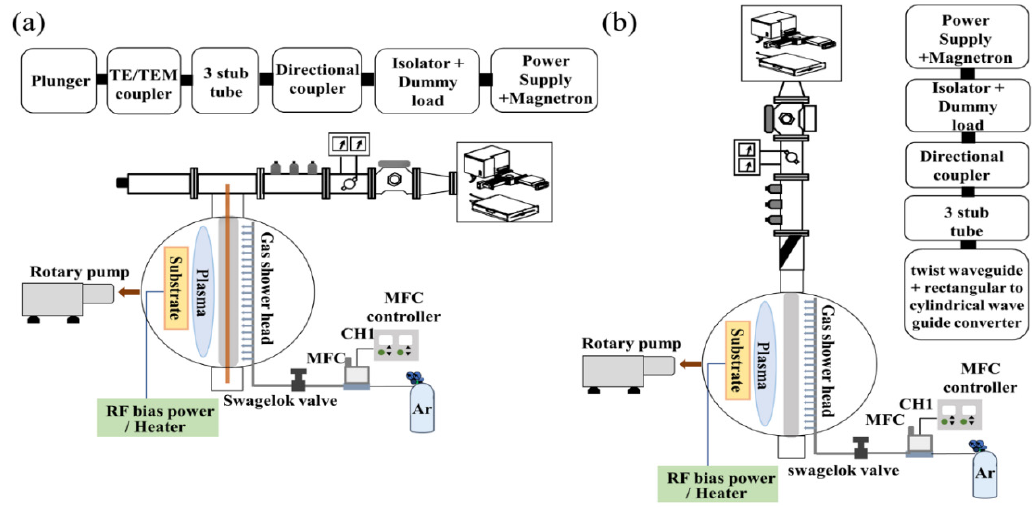
Figure 3. Schematic of the experimental system showing the microwave coupling arrangement. ( a ) Quasi-coaxial TEM linear MWP and ( b ) circular TE 11 waveguiding structure.